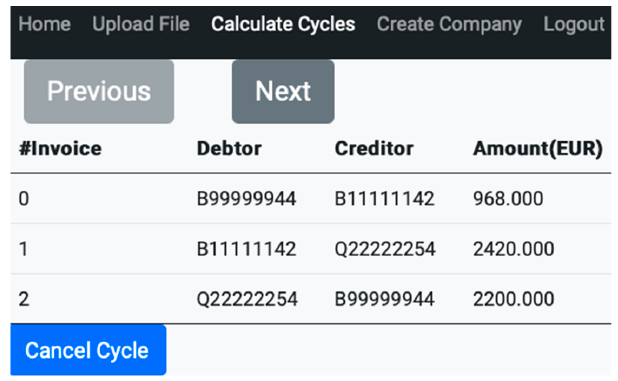
Figure 10. Transactions for cycle cancelation.